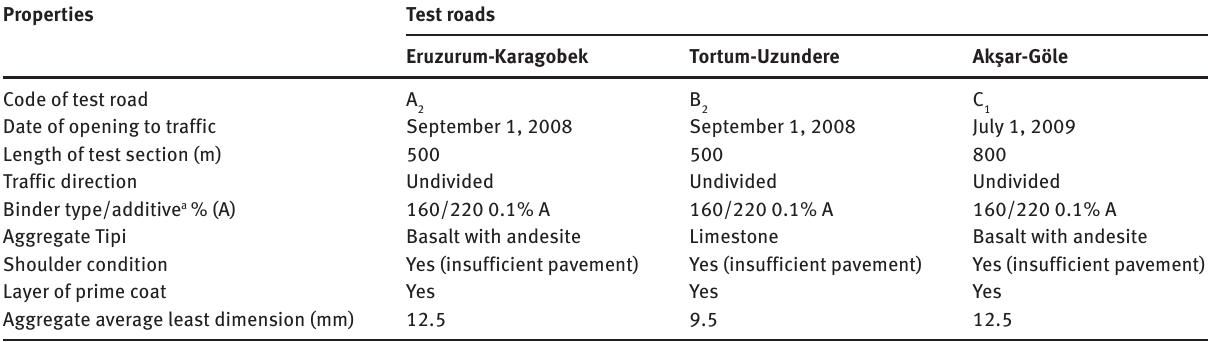
Table 1: Characteristics of test sections. Properties